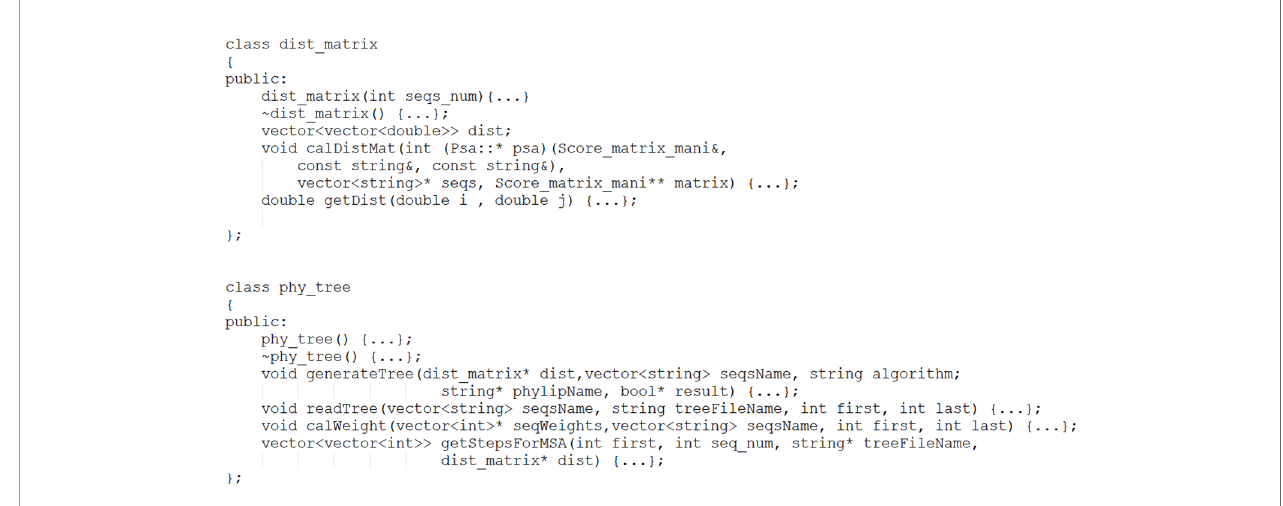
FIGURE 5 | Result of ADT